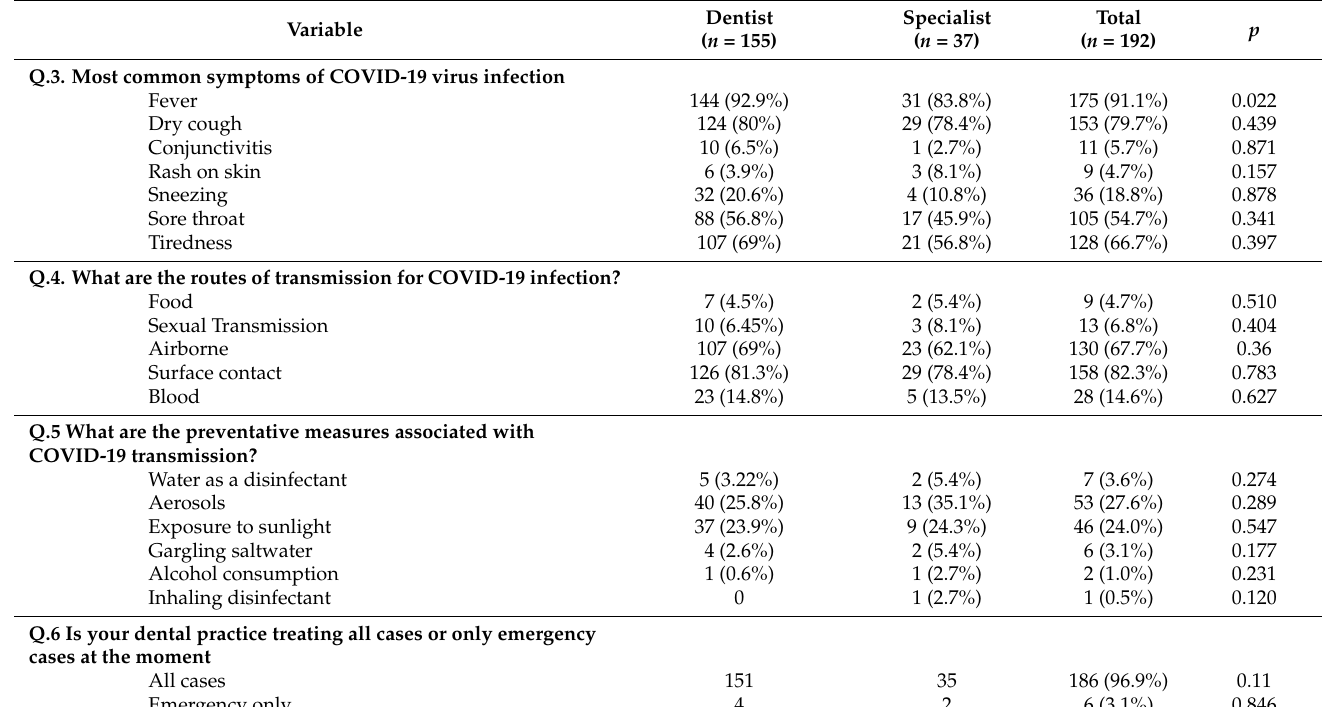
Table 2. Chi-square and Fisher exact test results for knowledge and awareness of COVID-19 by the dental profession, p <